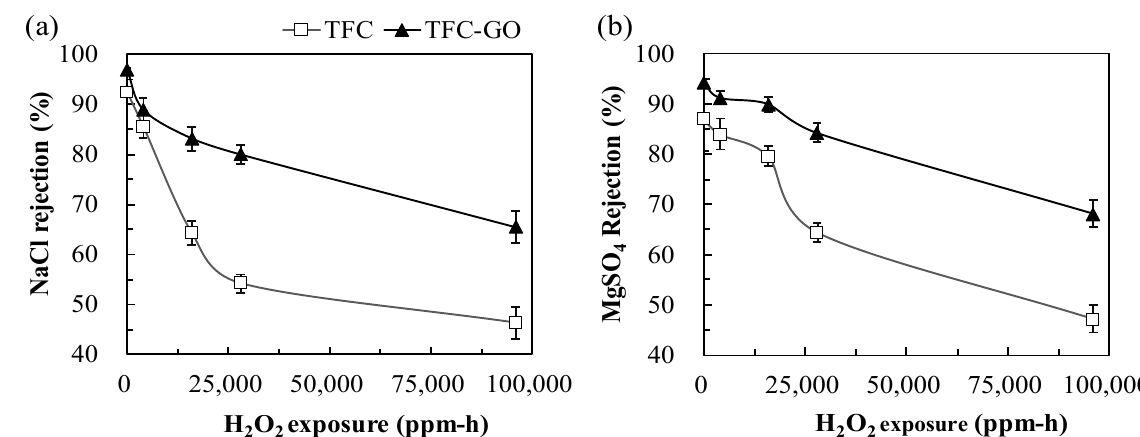
Figure 6. ( a ) NaCl and ( b ) MgSO 4 rejection by TFC and TFC-GO membranes with the range of 0 − 28,000 ppm-h H 2 O 2 exposure. Error bars represent one standard deviation of triplicate measure- ments.